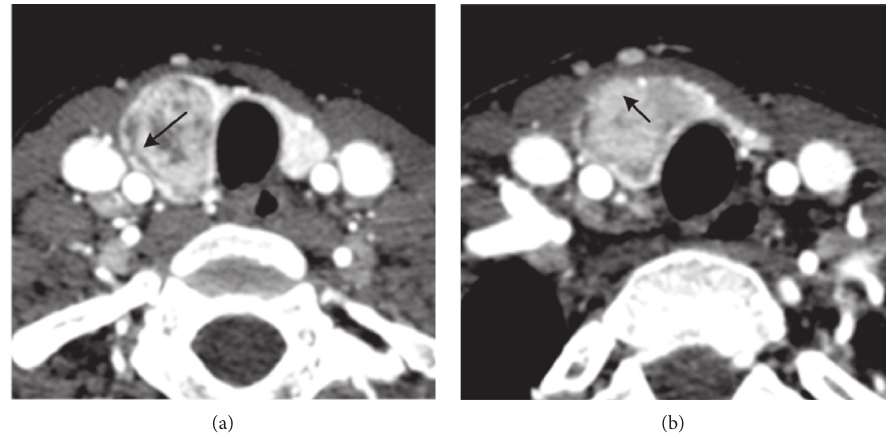
Figure 2: Low-density nodule in the right lobe of the thyroid, in a female, 27 years old. (a) The low-density ring sign has sharp horn protuberance at the edge ( ↑ ). (b) The lower level of (a) showing the irregularity of the low-density ring and the local interruption ( ↑ ).